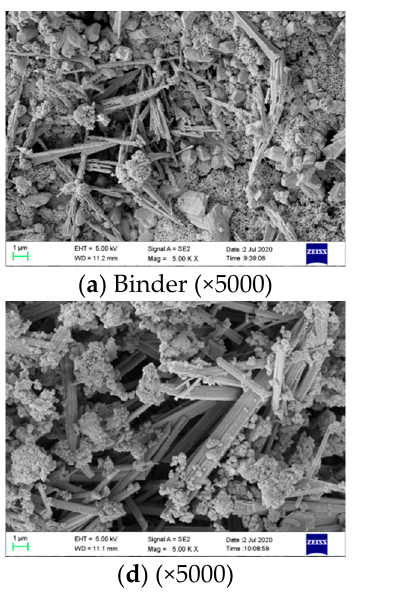
4 5 2 Figure 11. XRD patterns of RM-based SFLAs at 28 d hydration. 3.4. Microstructure. Analysis of RM-Based SFLAs The SEM images of binder material, RM, and RM-based SFLAs are presented in Fig- ure 12. Figure12a presents the microstructure of binder hydration after 28 d, ettringite crystals are arranged in regular columnar form, the gaps between ettringite crystals were filled with gel produced by hydration and minerals not completely hydrated to obtain a denser structure, which gives the binder specimen a good macroscopic mechanical strength. Figure 12b presents the microstructure of the RM itself, RM samples were dis-